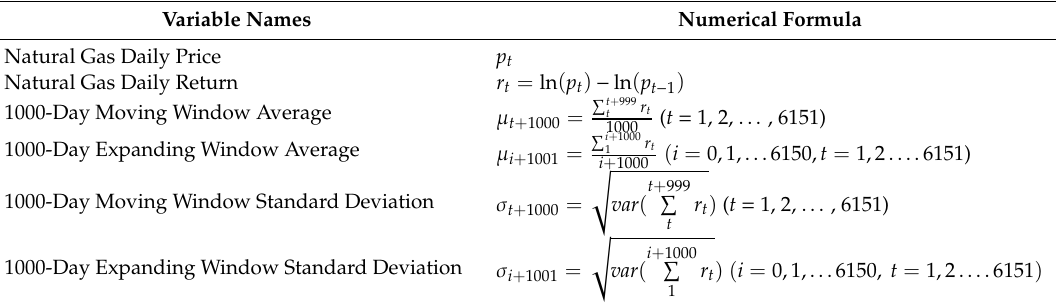
Table 3. Daily data set for the moving window and expanding